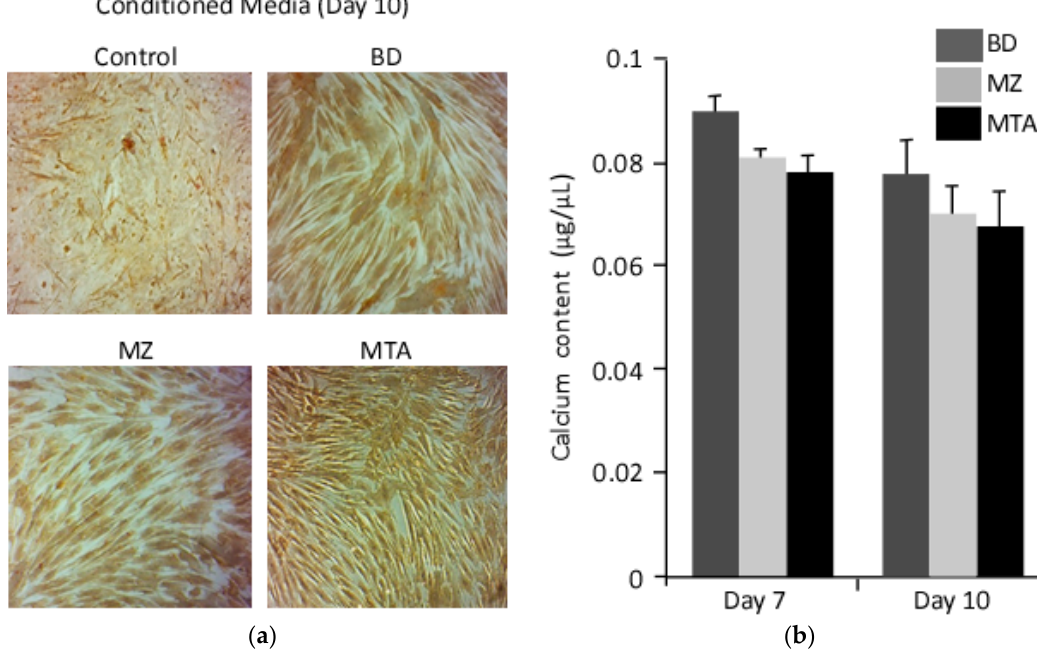
Figure 4. Calcium composition. ( a ) Calcium deposits were detected with Von Kossa at day 10. ( b ) Calcium cell composition was measured in differentiated DPPSCs seeded on the biomaterials conditional media, days 7 and 10.